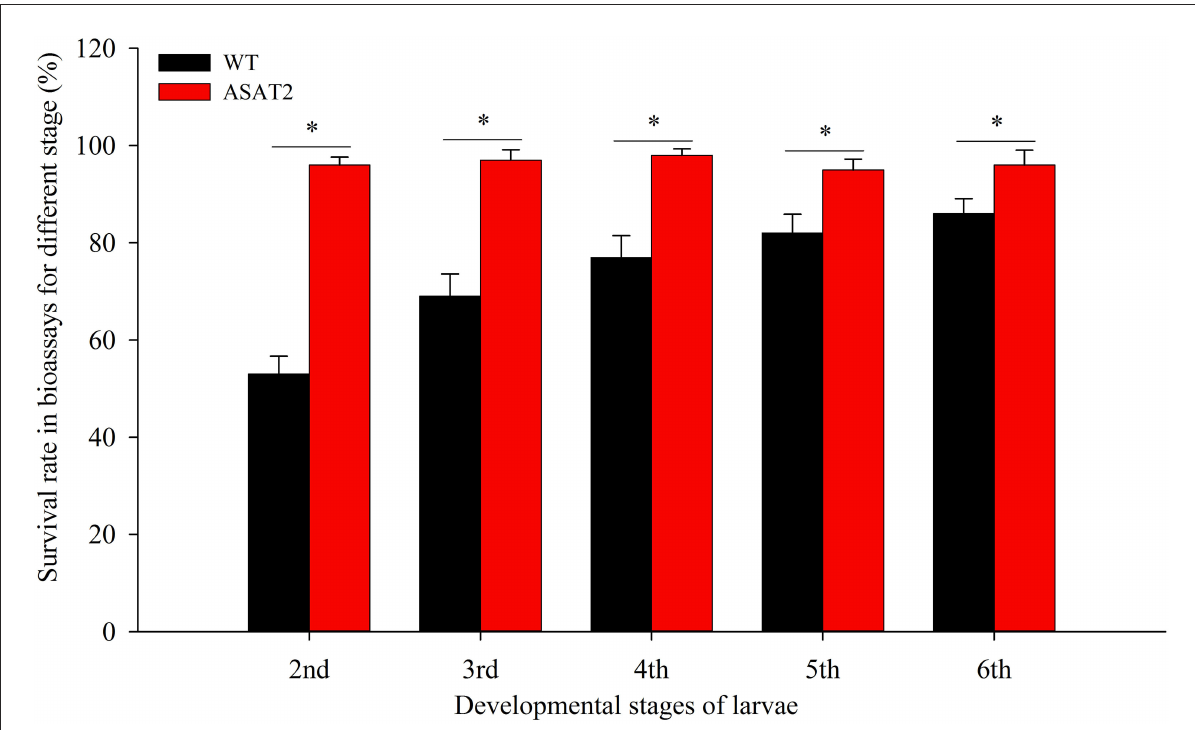
FIGURE1 Survival rate of bioassays using specific stages of larval instars on WT and ASAT2 plants of N. benthamiana. Values are presented as means ± SE. Asterisks above error bars indicate significant differences ( P < 0.05).